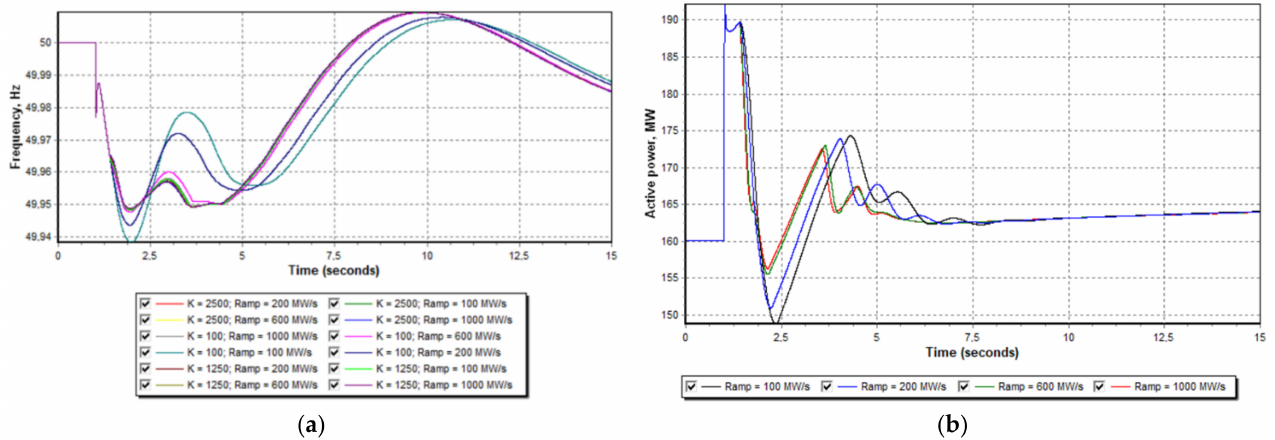
Figure 11. ( a ) Frequency dependence of the isolated power system on the frequency control parame- ters of the HVDC BtB converter. ( b ) The response of an active power to a load change when the gain is K = 100 MW/Hz.